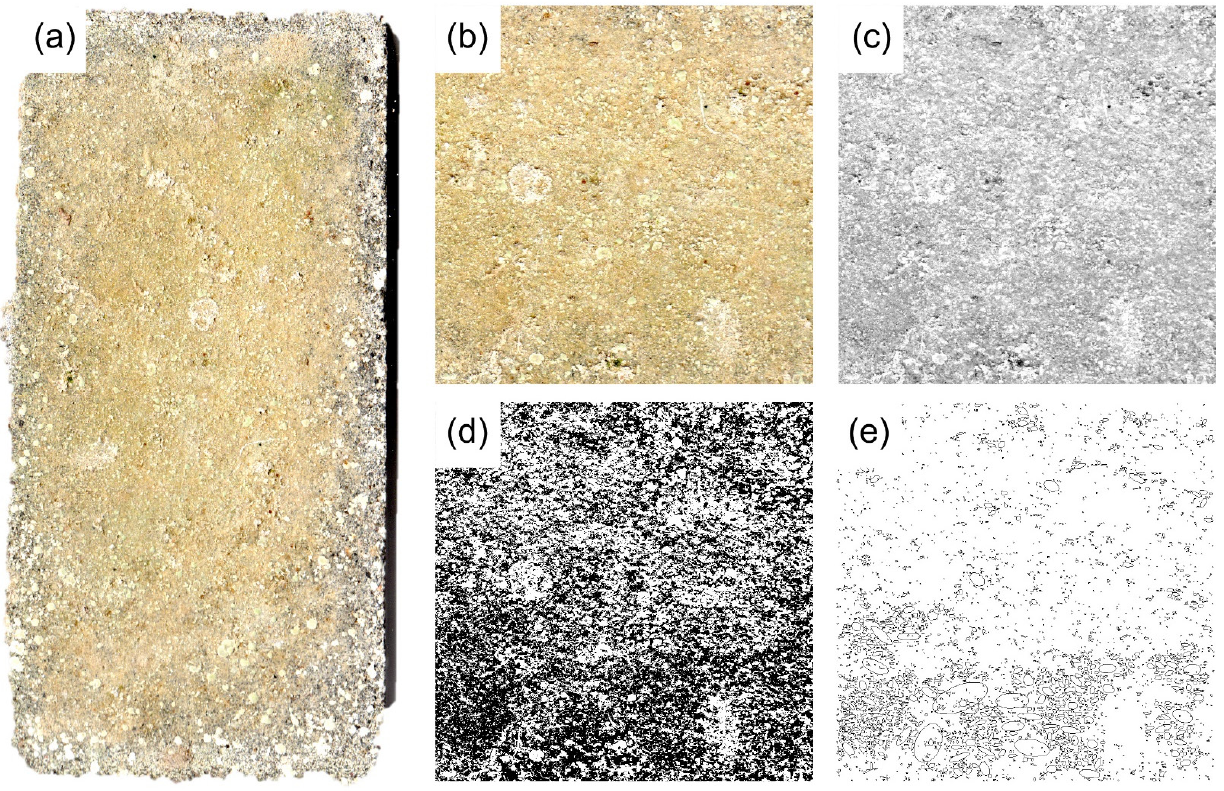
Figure 5. Images involved in the image analysis process for assessing the percentage of coverage. ( a ) Picture of the samples to be analyzed; ( b ) selected area; ( c ) reduction to an 8-bit image; ( d ) thresholding and subtracting process; ( e ) binary image ready to be analyzed.